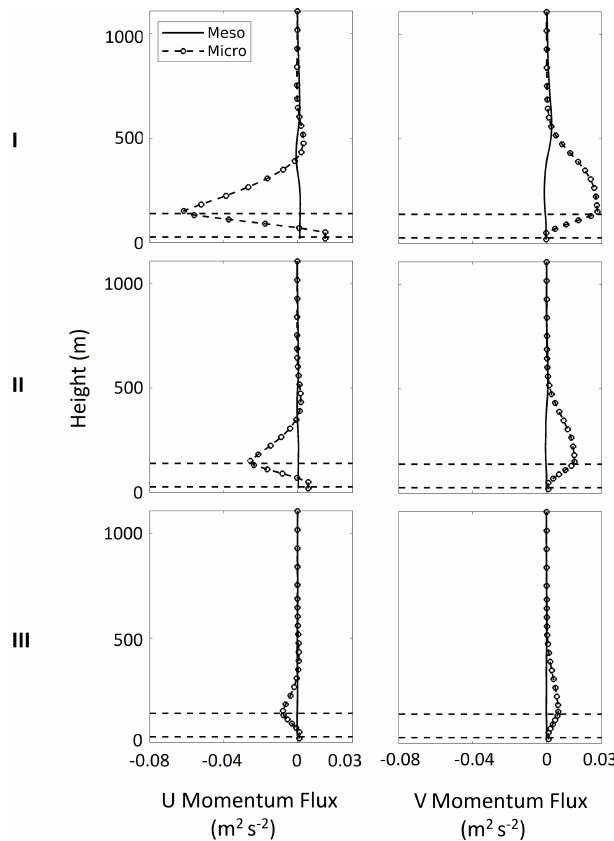
Figure 7. Difference (WF-CTRL) in vertical profiles of mesoscale (solid line), and microscale fluxes (--o--) averaged over the wind farm and 5 sea-breeze days for 12:30 to 17:30IST, for different cases. Horizontal black dotted line shows the height of the upper and lower tip of the wind turbine